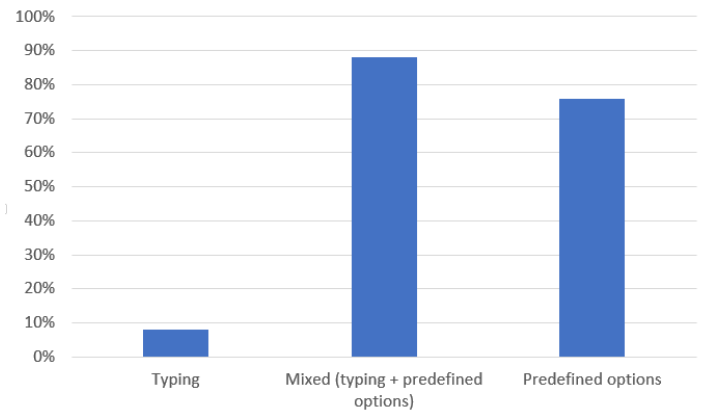
Figure 6. Perceived Interaction Usability.